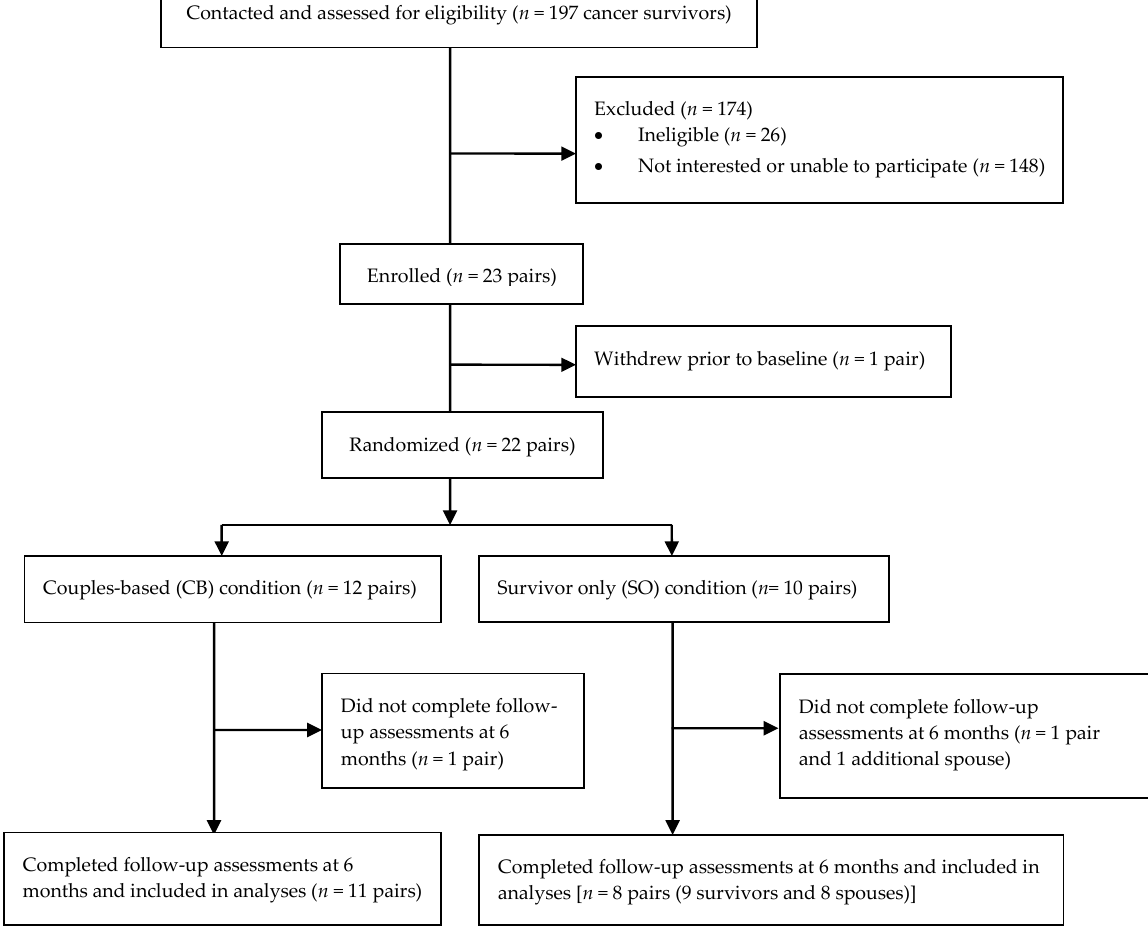
Figure 1. CONSORT flow diagram from recruitment to study completion.